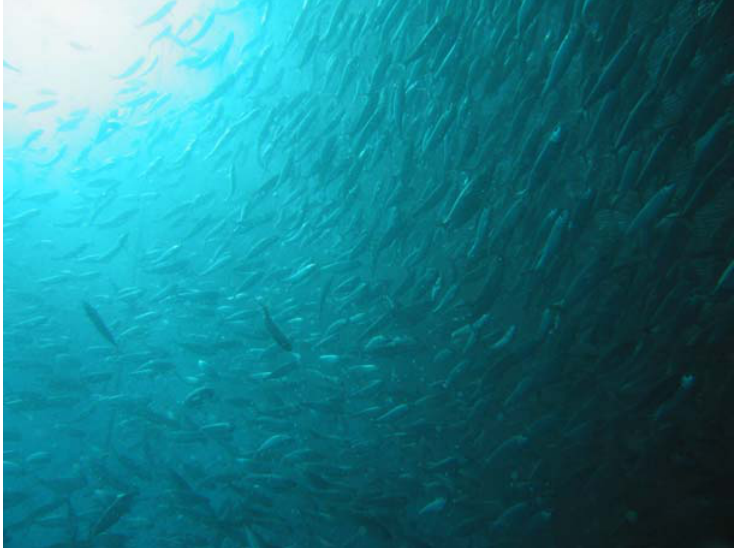
Figure 3. Picture showing wild fish aggregation in a fish farm in the Mediterranean Sea